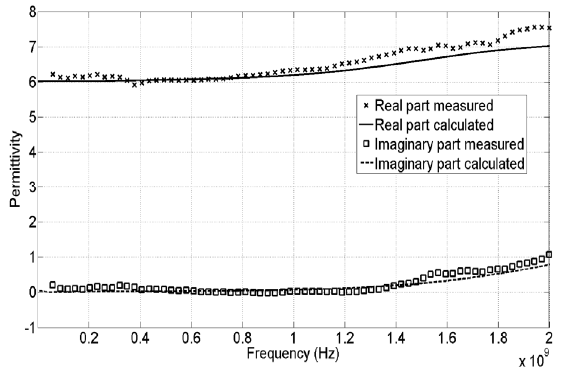
Figure 15. Imaginary part of the permittivity measured (lines) and calculated (dots) for different saturations.